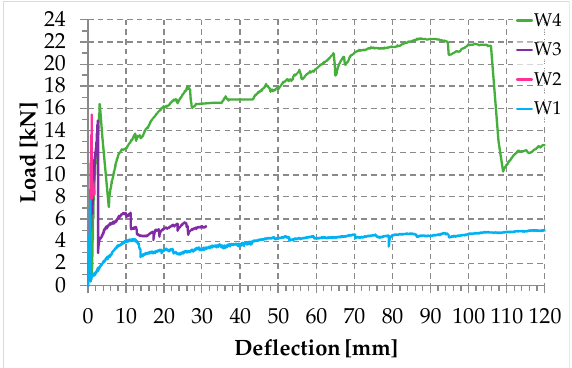
Figure 10. The load/deflection diagrams for the four specimens of the experimentation on the first Figure 10. The load / deflection diagrams for the four specimens of the experimentation on the first combined technique. combined